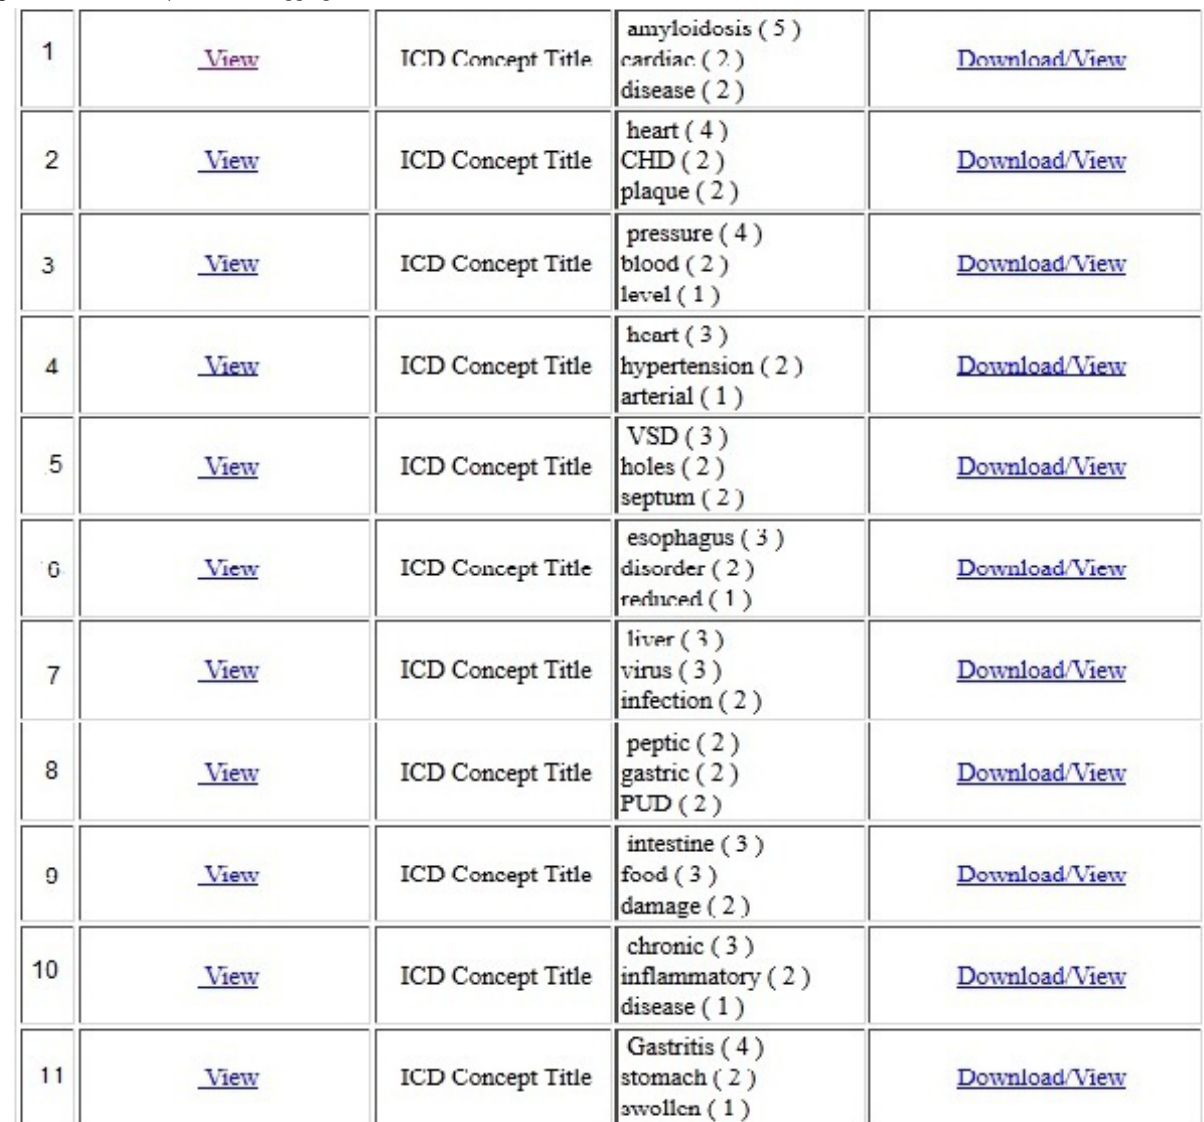
Figure 13. Collected posts on the aggregator